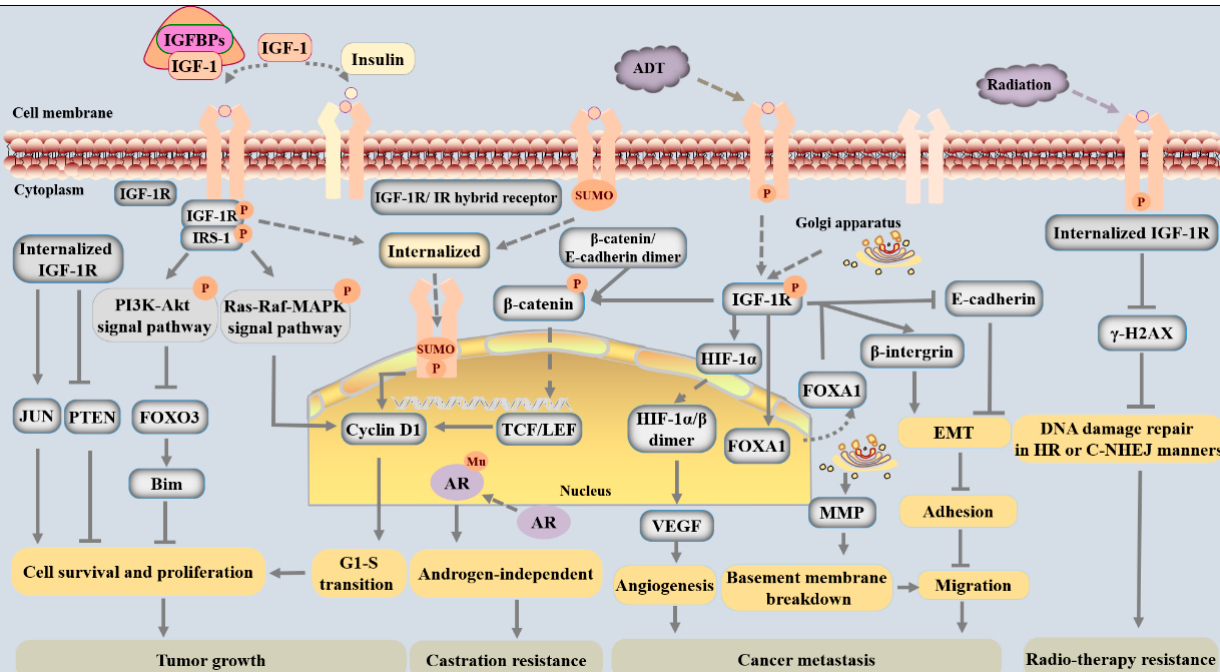
Figure 2. The detailed molecular mechanisms of activated IGF-1R in promoting cancer development and therapy resistance are schematically represented. IGF-1 exerts its biological functions via activating PI3K-Akt as well as Ras-MAPK signaling pathways via promoting phosphorylation and SUMOylation of its receptor IGF-1R. First of all, activated IGF-1R can promote survival and proliferation and inhibit apoptosis of cancer cells by regulating the expression of cell cycle proteins, oncogenes, and tumor suppressor genes, such as cyclin D1 , JUN , and PTEN . Secondly, activated IGF-1R can induce angiogenesis in the tumor microenvironment by enhancing VEGF expression. It can also promote cancer cell migration via regulating cell adhesion-associated proteins, and then promoting EMT. In addition, IGF-1R can promote degradation of ECM components by stimulating MMP release. All these biological functions would enhance the ability of metastasis for cancer cells. Thirdly, IGF-1/IGF-1R would favor the progression of androgen-independent PCa due to stimulating nuclear translocation of AR and affecting the AR androgen-binding domain or phosphorylation status for mutation. Lastly, activated IGF-1R can promote DNA damage repair and radioresistance of cancer cells by inhibiting DNA damage-related proteins and promoting castration resistance for androgen receptor mutation.